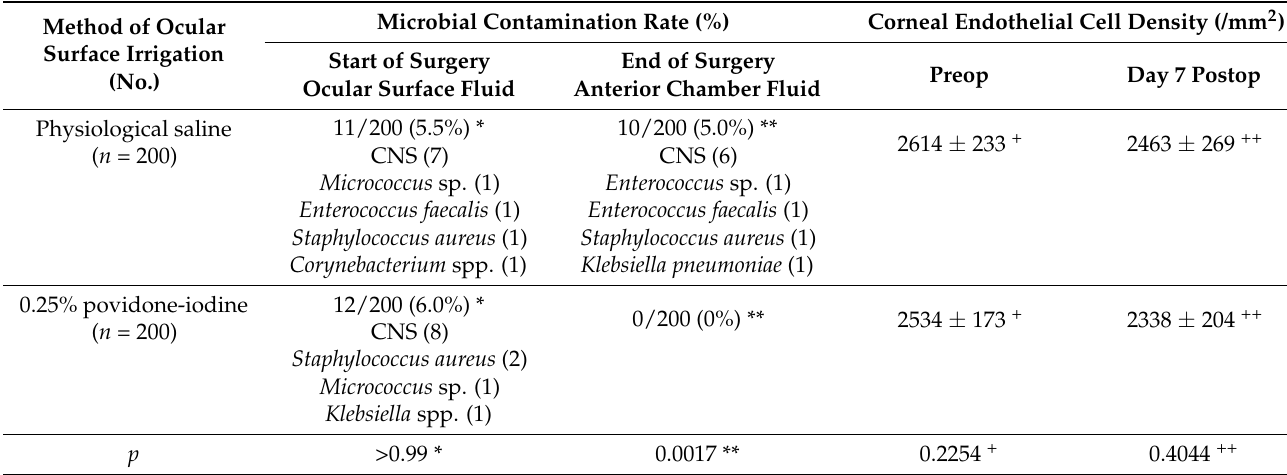
Table 3. Bacterial contamination rate, and corneal endothelial cell density when 0.25% povidone-iodine was used to repetitively irrigate the ocular surface during cataract